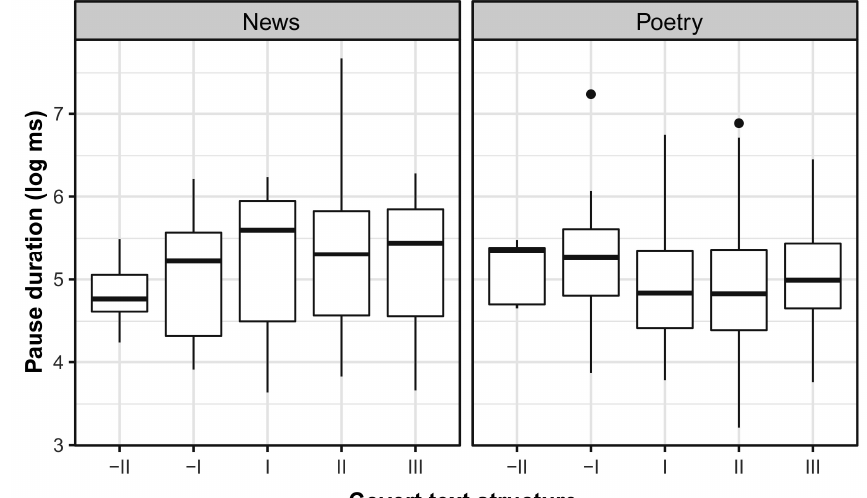
Figure 4. Boxplots of log pause duration in two genres as a function of the grammatically informed analysis according to Franz et al. (2022). For an explanation of levels, see Section 2.3.